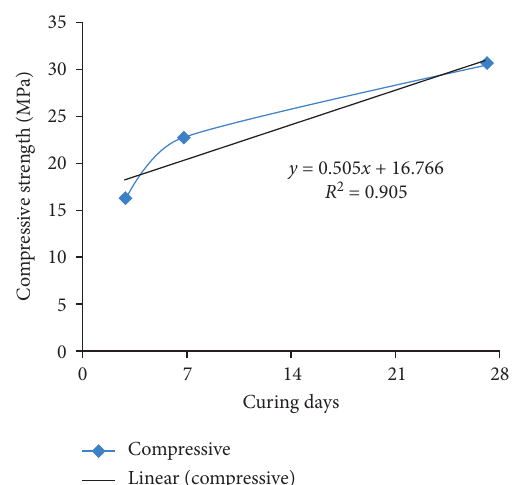
Figure 8: Temporal variations in flexural strength of the impro- vised concrete